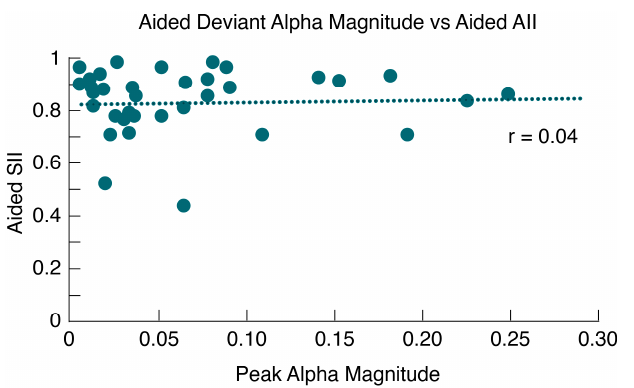
Figure 7. Alpha magnitude as a function of aided speech intelligibility (SII) . Alpha magnitudes for the deviant response in the unaided condition are represented along the abscissa and aided SII scores are represented along the ordinate. A correlation analysis revealed no signi fi cant correlation between alpha magnitude and aided SII ( r = 0.04, p > 0.05).